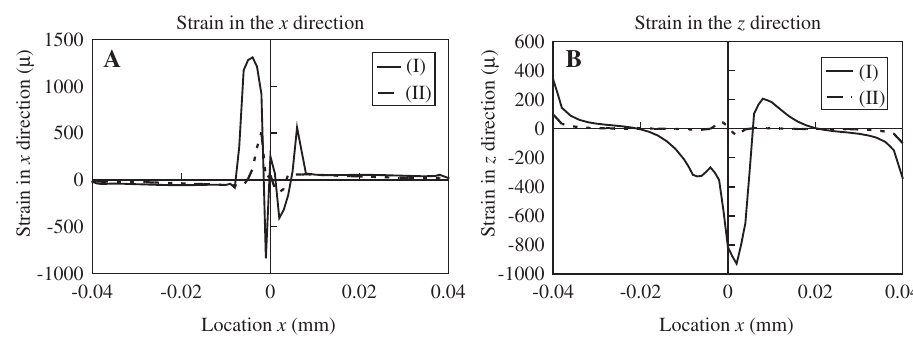
Figure 5 Residual strain distribution of the specimen surface along the x direction obtained by FEM analyses.